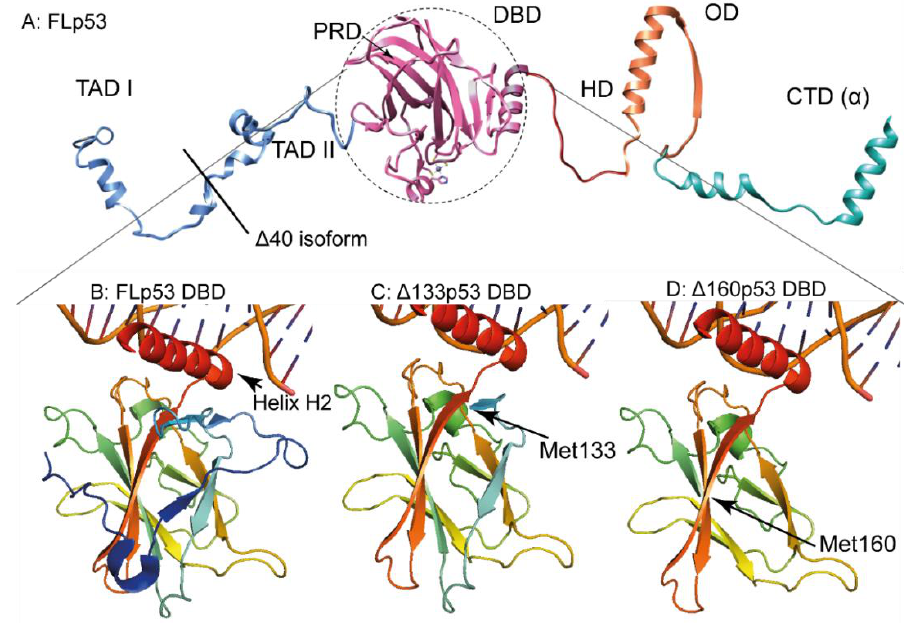
Figure 2. FLp53 and its isoforms ∆40, ∆133, and, ∆160. ( A ) A schematic representation of FLp53α with its five domains clearly designated: the N-terminal domain with transactivation domains I and II (TADI and TADII; blue), the DNA binding domain (DBD; pink), the hinge domain (HD; red), the oligomerization domain (OD; orange) and the carboxy-terminal regulatory domain (CTD; green). The NTD structure is assembled by superimposition of pdb ID 2K8F (Chain B, residues 1 – 35) and 2B3G (chain B, residues 35 – 56). The DBD and OD were derived from pdb ID 3TS8. The model is (chain B, residues 35–56). The DBD and OD were derived from pdb ID 3TS8. The model is created in created i n Chimera. The start of the ∆40p53 isoform is indicated by a black line. ( B – D ): Close-up on Chimera. The start of the ∆ 40p53 isoform is indicated by a black line. ( B – D ): Close-up on the DBD the DBD in FLp53 and its two isoforms modeled in Pymol based on pdb ID 3TS8. Figures demonstrate how the shorter isoforms ∆133p53 and ∆160p53 lack β -sheet stabilizing strands. B: DBD of the FLp53. C: DBD of the ∆133p53 isoform starting with Met 133 . D: DBD of the ∆160p53 isoform starting with Met 160 .